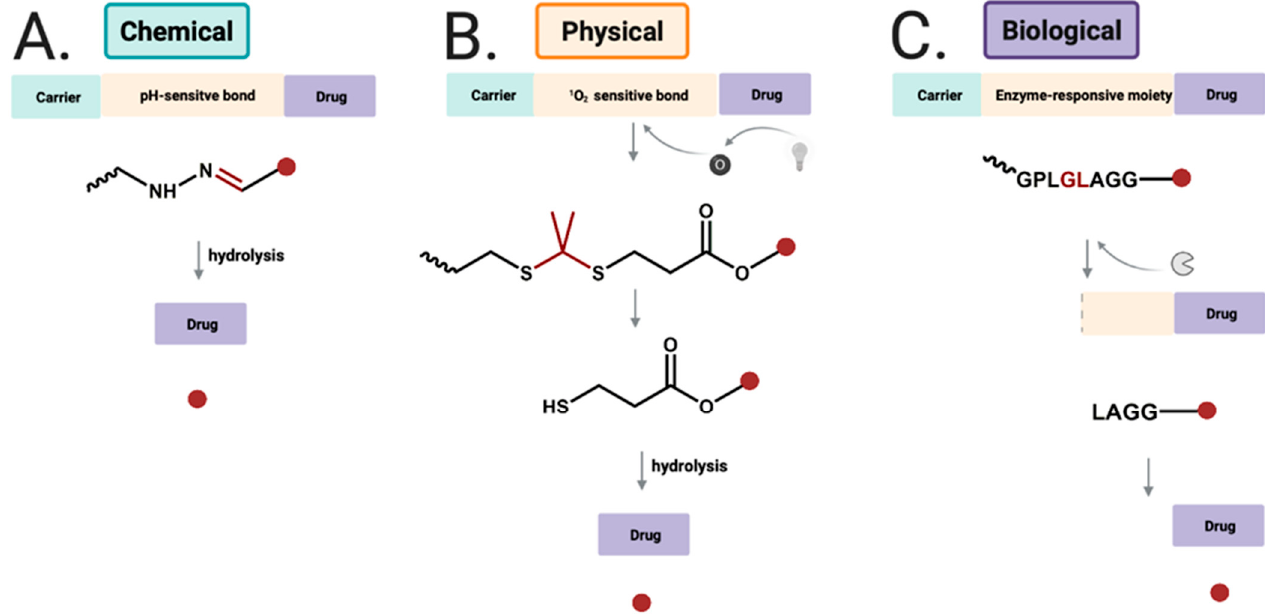
Figure 6. Drug release strategies for ( A ) chemical-responsiveDDSs by hydolysis of hydrazone bond to release free drug; ( B ) physical-responsive DDSs using near infrared light to generate singlet oxygen, which undergoes reaction with thioketal group; ( C ) biological-sensitive DDSs cleaved byenzyme, and further cleaved to release free drug.